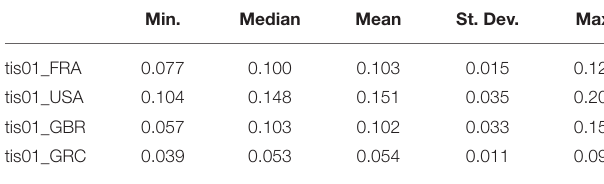
TABLE 2 | 1% Top income share: summary statistics. Min.